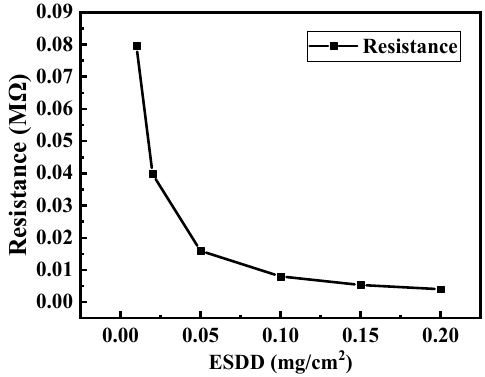
Figure 11. The relationship between ESDD and surface resistance.